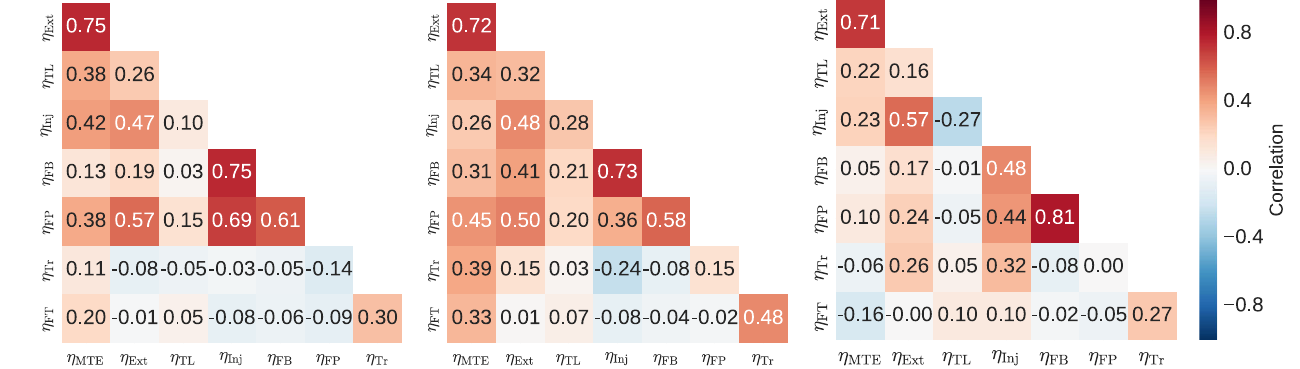
FIG. 18. Correlation heat maps for the figures-of-merit used in the analysis. The three plots refer to the different MTE beam intensities, namely N p ¼ 1500 , 1800, 2000 ppp for the left, center, and right panel, respectively. It is worth noting that the general tendency of correlations was found to be positive.